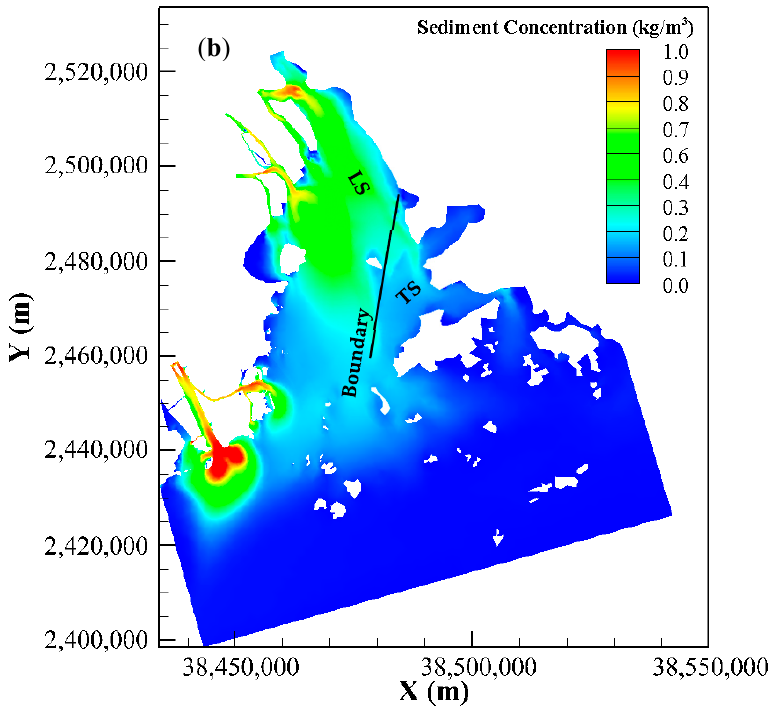
Figure 9. Sandbar simulation: the distribution of sediment concentration (LS: Lingding shallows; TS: Tonggu shallows). ( a ) at flood fast tide; ( b ) at ebb fast tide.